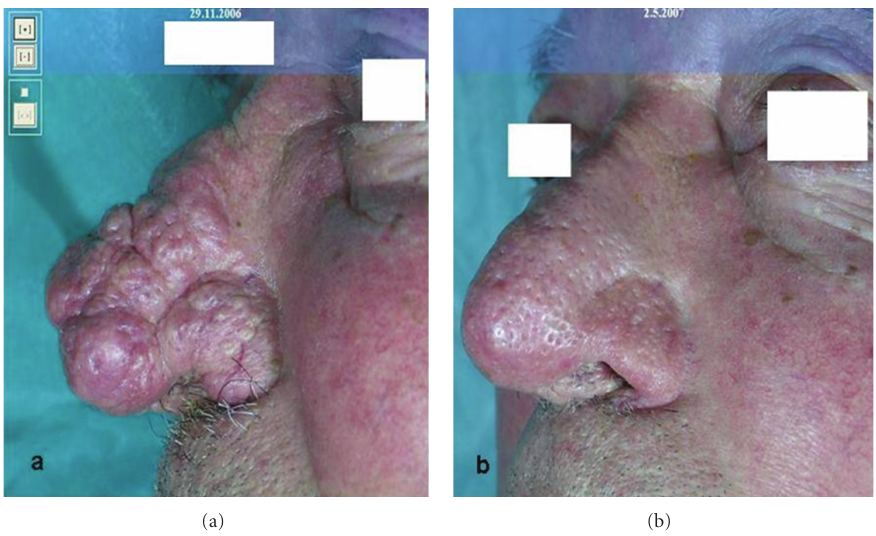
Figure 2: Rhinophyma at first (a) and after (b) five treatments with CO 2